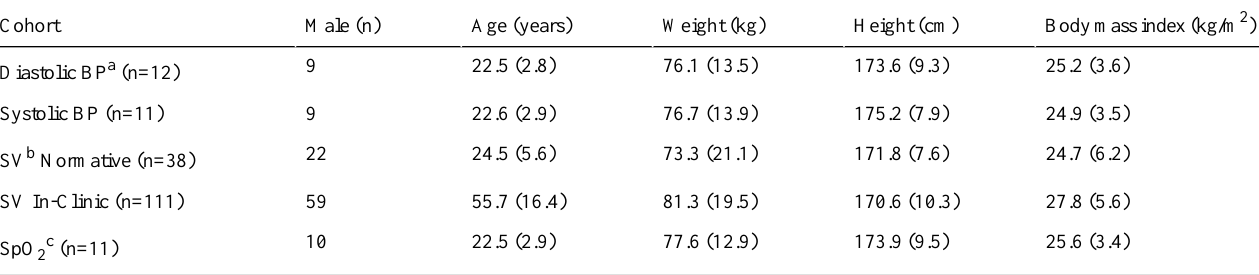
Table 1. Demographic information for the cohorts used to validate each of the seat measures. These statistics only include data that have passed the automated signal quality